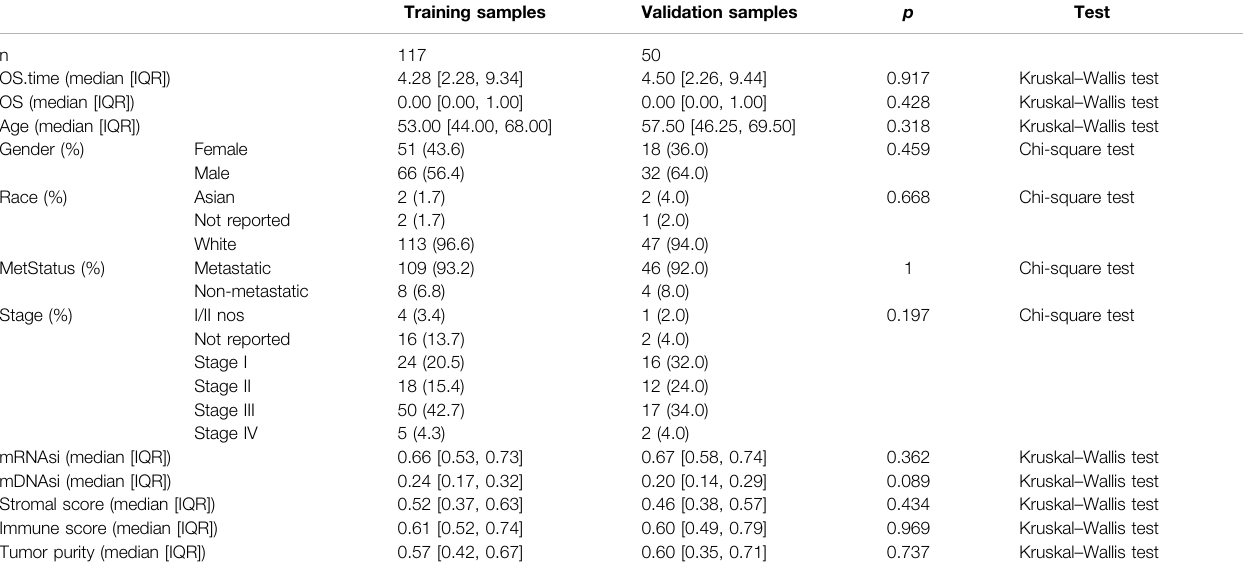
TABLE 2 | Clinicopathological variables of training and validation dataset. IQR means interquartile range. Training samples Validation